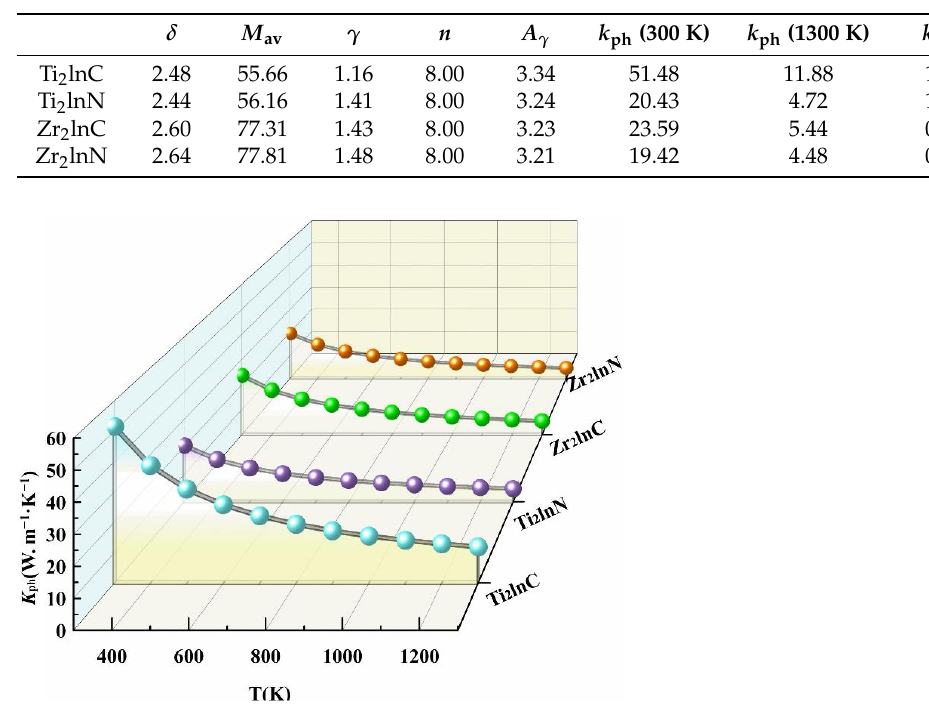
Figure 10. Lattice thermal conductivities k ph of M 2 InX (M = Ti, Zr and X = C, N) MAX phases in the temperature range of 300 K–2000